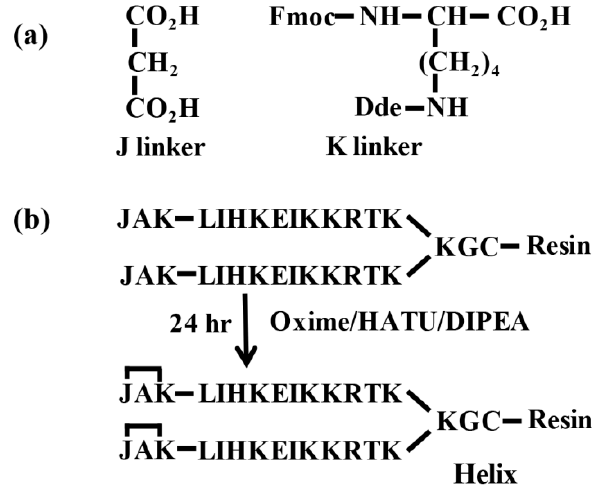
Figure 5. ( a ) Structure of J and K linkers. ( b ) Insertion of nucleation site into a helix-like peptide during solid-phase synthesis.